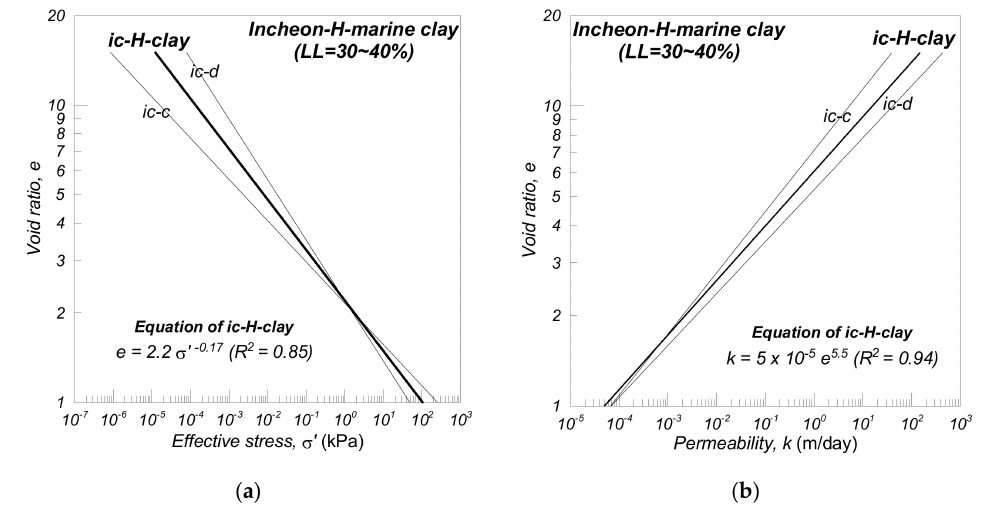
Figure 15. Constitutive relationship of Incheon H marine clay (ic-H-clay): ( a ) void ratio vs. e ff ective stress; ( b ) void ratio vs. permeability.